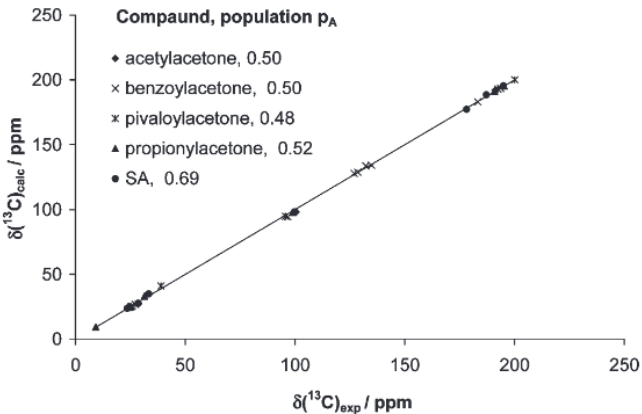
Figure 15. Plot of calculated vs. calculated 13 C chemical shifts for β -diketones. Taken from Ref. [93] with permission from the American Chemical Society.